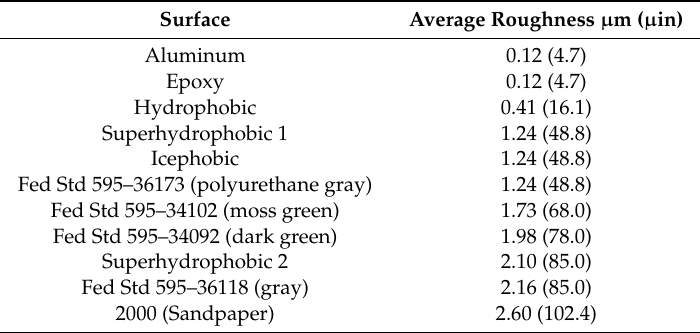
Table 5. Comparison of the roughness of the surfaces tested with currently used camouflage